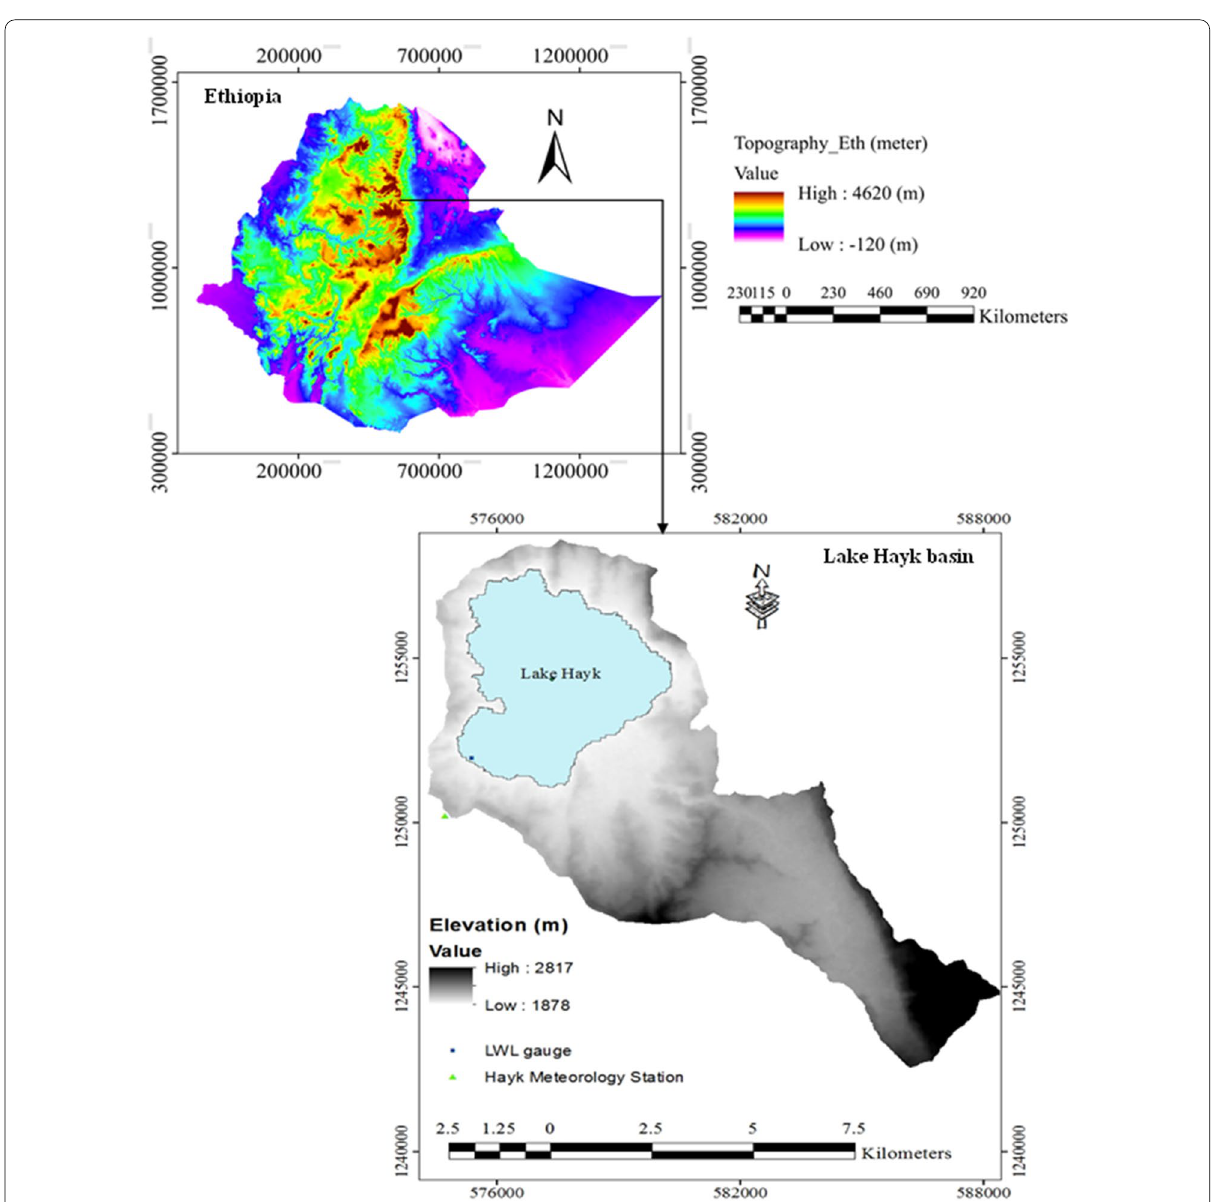
Fig. 1 Map depicting Ethiopia’s diverse topography (upper) and a map depicting the location of the Endorheic Lake Hayk basin in Ethiopia, as well as the location of the meteorological station and lake level measuring gauge in the Lake Hayk basin